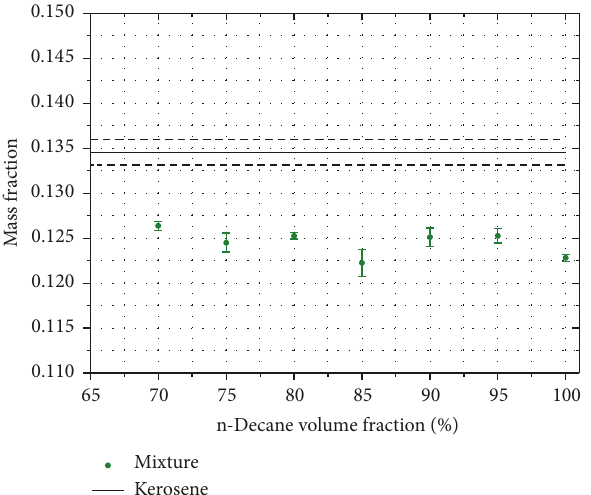
Figure 8: Comparison of mass fraction of H2O for the surrogate and the kerosene